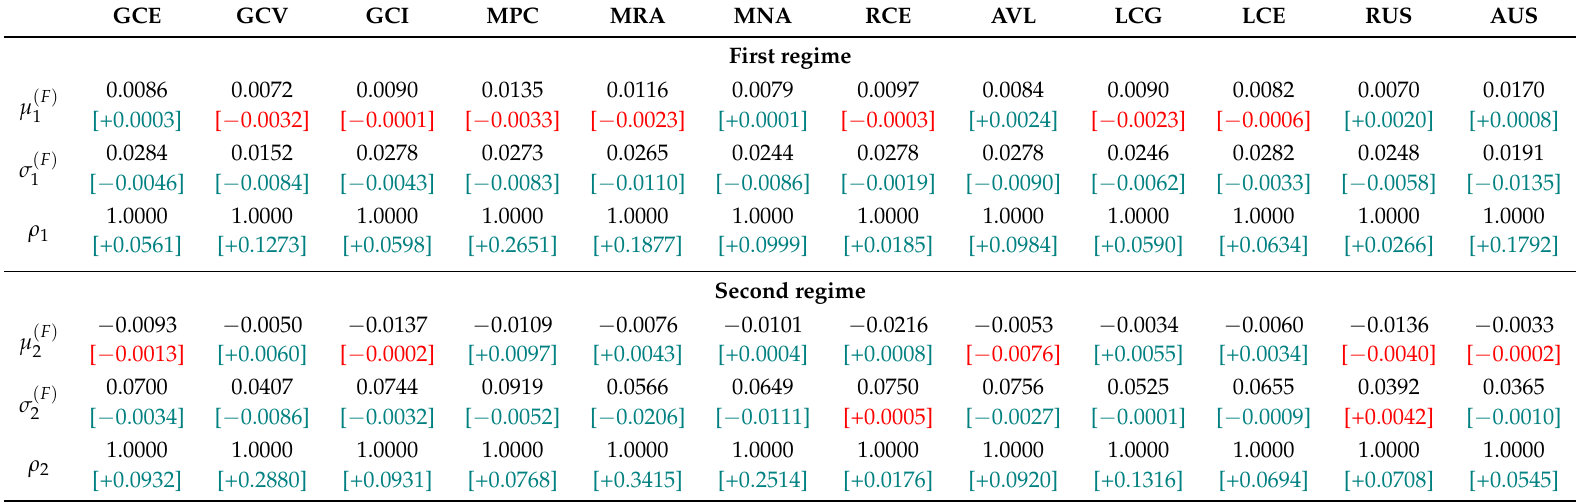
Table 6. Calculation of the fund mapping parameters obtained under constraints (3) assuming no basis risk (i.e., σ M = 0) for the various funds described in Table 1. The difference compared to the unconstrained model (see Table 2) is given in brackets. Teal brackets indicate an improvement from the perspective of the insurer performing the hedge (i.e., higher mean, lower volatility, or higher correlation), and red brackets indicate a worsening (i.e., lower mean, higher volatility, or lower